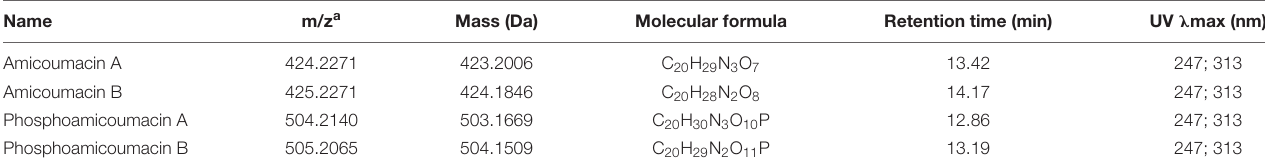
TABLE 2 | List of amicoumacins characterized by UV-absorbance and mass spectrometry from the 11–20 min region of the BPI-chromatogram issued from the CFS of B. pumilus 35R